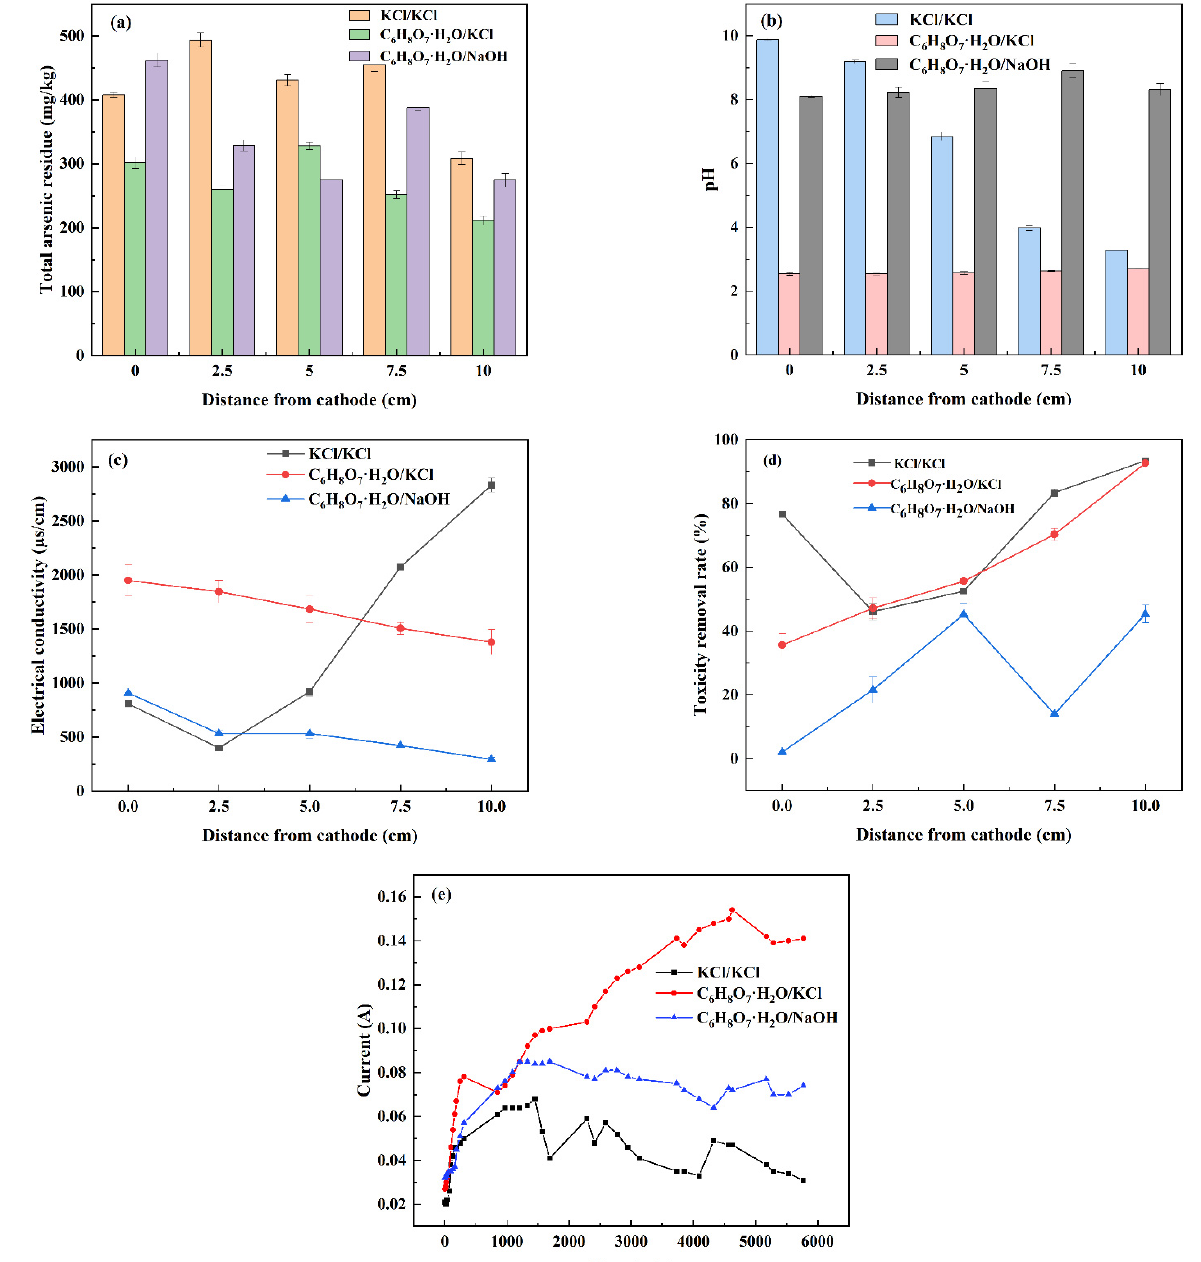
Figure 6. Effect of electrolyte type on polarization phenomenon for the remediation of arsenic contaminated soil by EK-PRB. Total arsenic residue ( a ), pH ( b ), electrical conductivity ( c ), toxicity removal rate ( d ) and current ( e ).